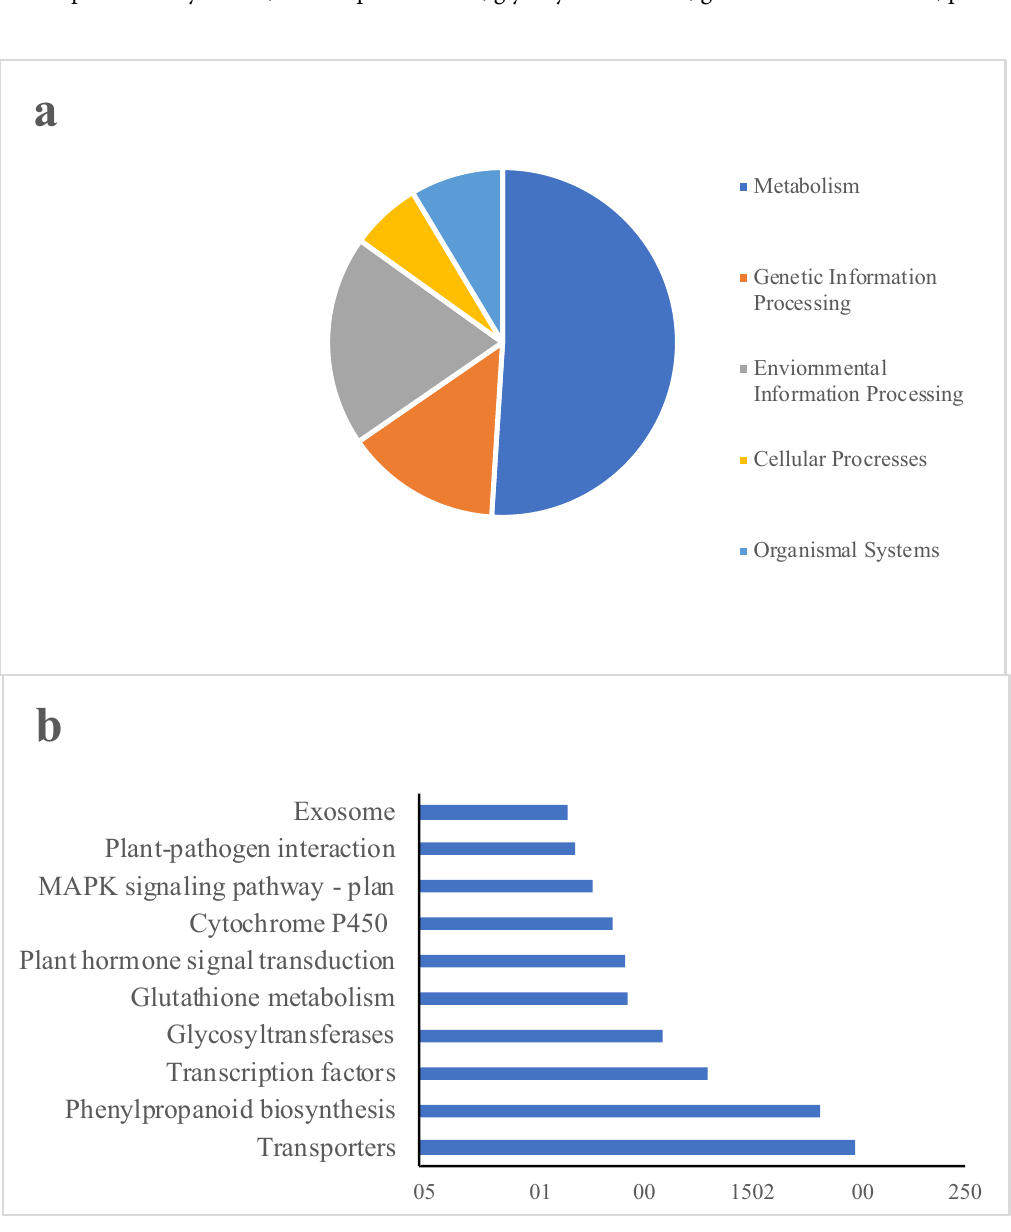
Fig 3. KEGG classification of the DEGs. (a) KEGG distribution of the annotated genes into 5 main categories.(b) The top 10 pathways with the highest number of